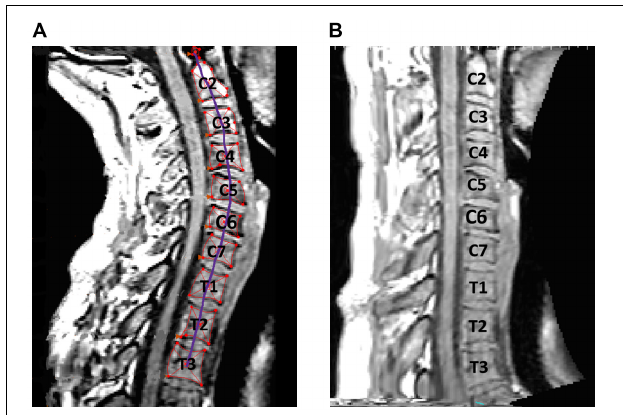
FIGURE 1 | (A) Centroids for each cervical vertebra were determined. (B) Spline curve through centroids was used to produce a re-sliced scan that standardized neck curvature across subjects.